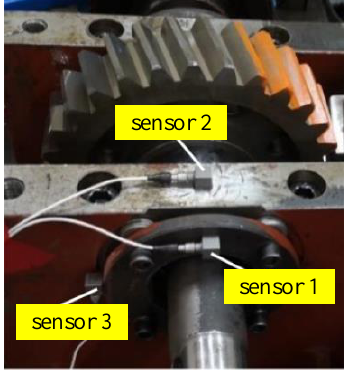
Figure 5. Position of the acceleration